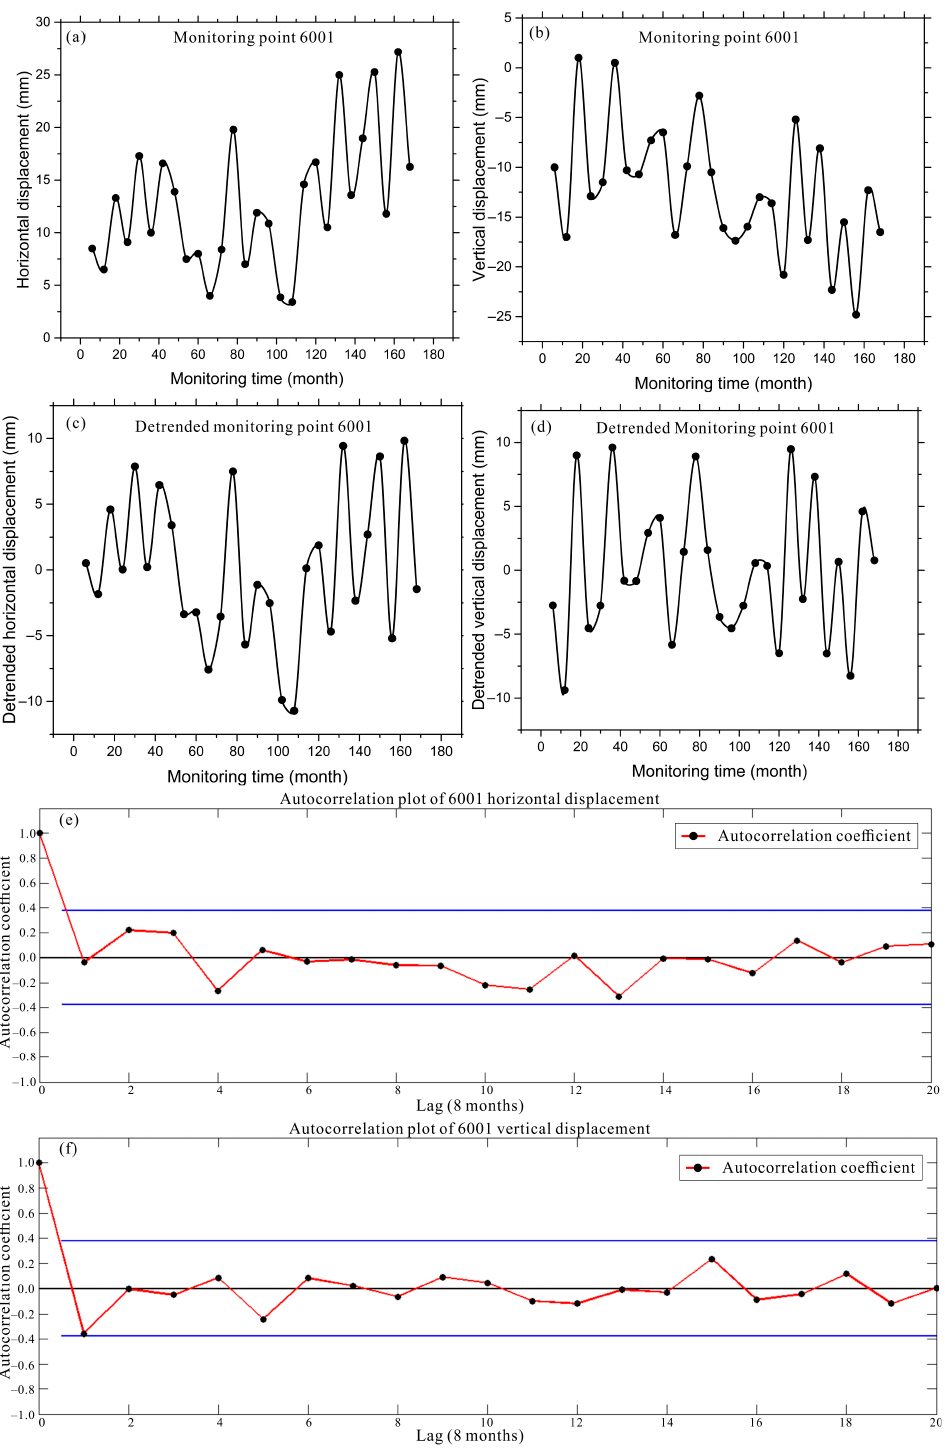
Figure 5. Non-detrended and detrended vertical and horizontal displacement time series and autocorrelation plots of the monitoring point 6001 at the Jinchuan Nickel Mine: ( a ) Horizontal displacement, ( b ) vertical displacement, ( c ) detrended horizontal displacement, ( d ) detrended vertical displacement, ( e ) autocorrelation plot of horizontal displacement, ( f ) autocorrelation plot of vertical displacement.